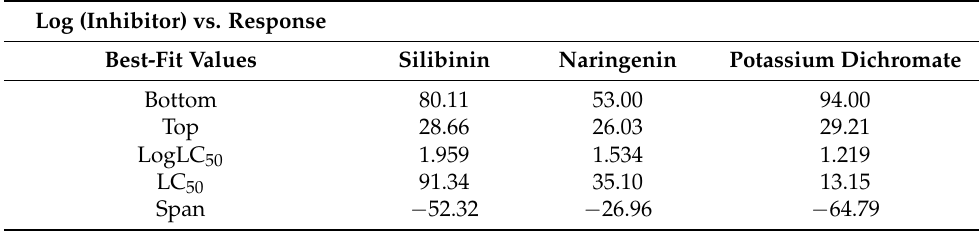
Table 4. LC 50 values for silibinin, naringenin, and potassium dichromate.